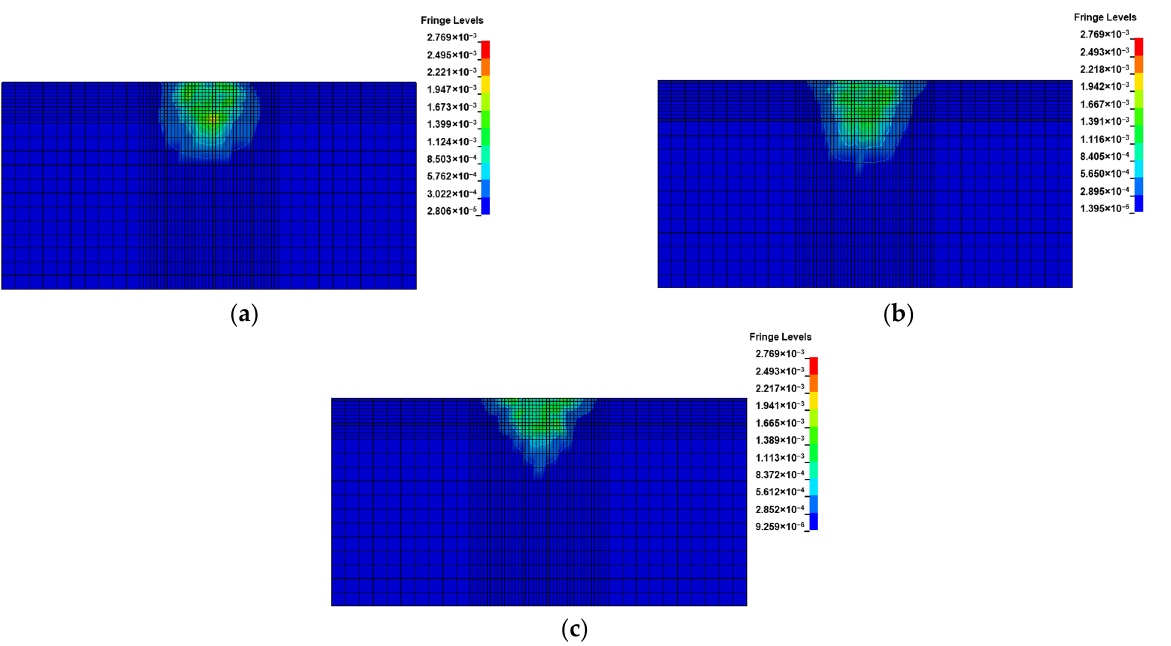
Figure 18. Stress contour of rock breaking by disc cutter with 22 mm blade width. ( a ) Stress contour of rock breaking (Blade fillet 0 mm); ( b ) Stress contour of rock breaking (Blade fillet 5 mm); ( c ) Stress contour of rock breaking (Blade fillet 9 mm).